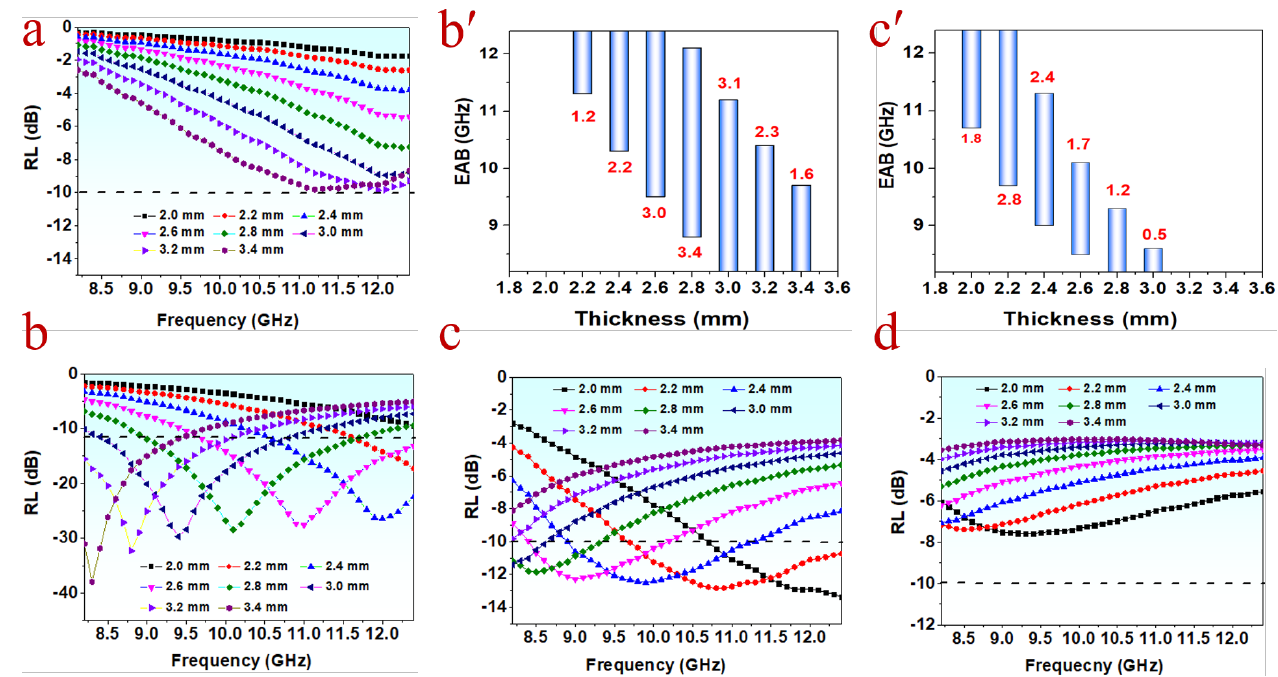
Figure 2. RL plots of PPyNT/NR/NBR (50/50) with ( a ) 3 phr PPyNT, ( b ) 6 phr PPyNT, ( c ) 9 phr PPyNT, ( d ) 12 phr PPyNT and EAB of PPyNT/NR/NBR (50/50) with ( b’ ) 6 phr PPyNT and ( c’ ) 9 phr PPyNT.